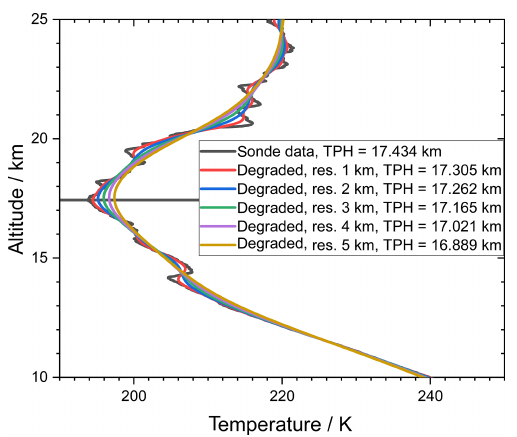
Figure 5. An example of a radiosonde profile, Nairobi, 1.27 ◦ S, 36.8 ◦ E, 7 July 2010, at original vertical resolution along with de- graded profiles at vertical resolutions of 1 to 5km. Contrary to the example shown in Fig. 1, the smoothed profile is represented on the native radiosonde grid, not on the 1km regular grid. For details, see Fig.